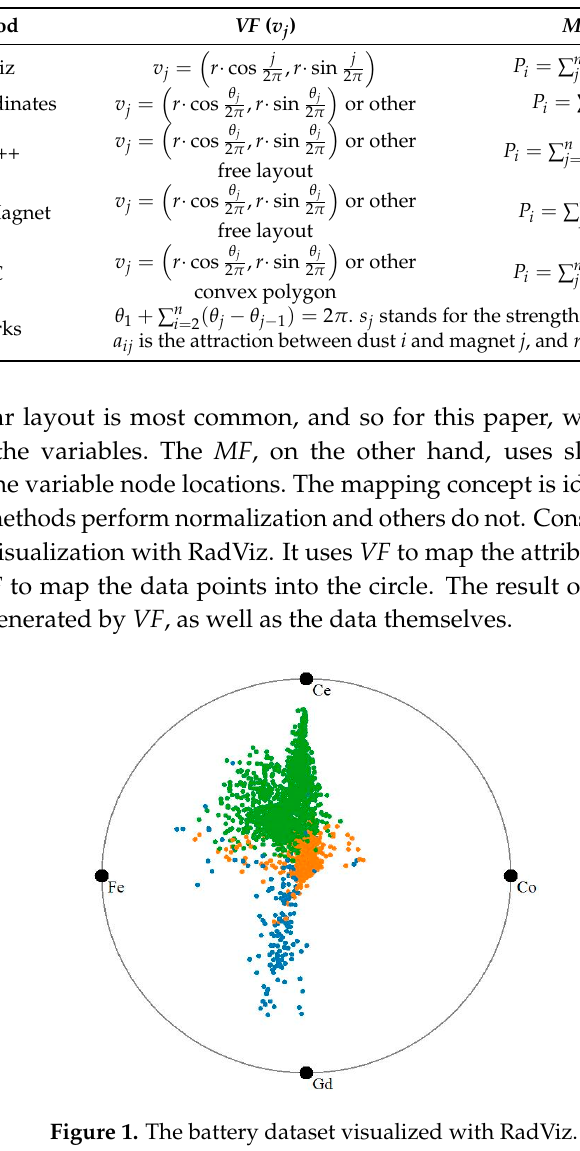
Figure 2. Generalized barycentric coordinate interpolation.